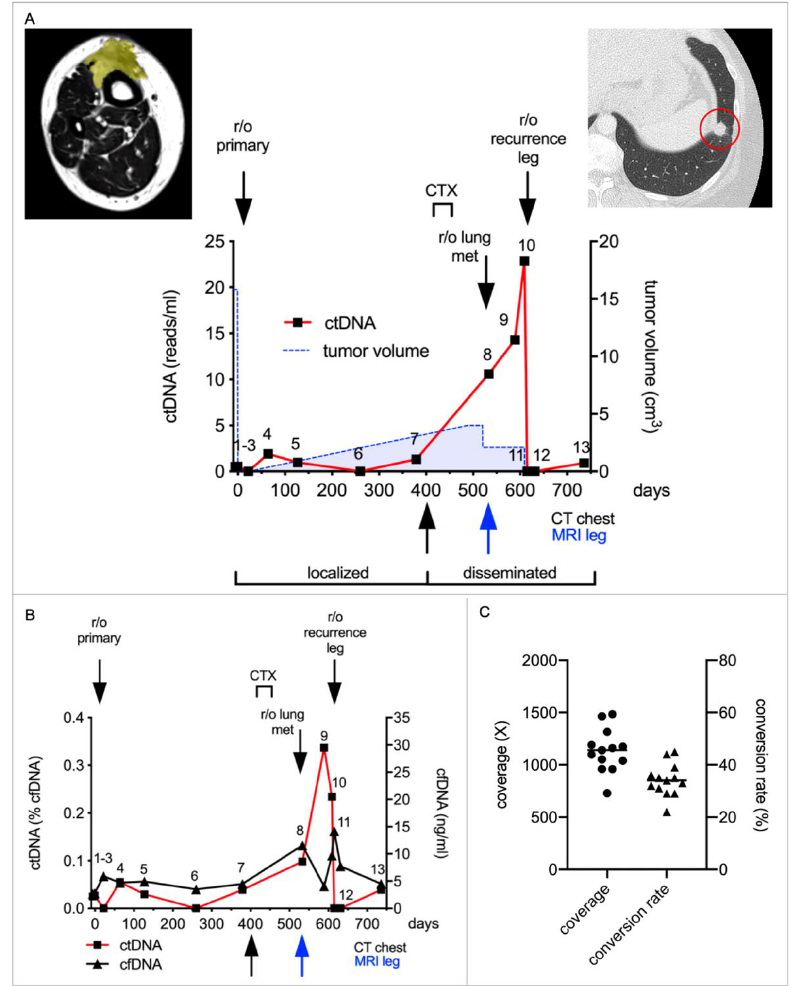
Figure 2. ctDNA enables the detection of local and distant metastases in a patient with leiomyo- sarcoma. ( A ) The patient presented with a primary tumor (yellow, volume: 15.8 cm 3 ) on her shin which infiltrated the tibia as demonstrated in the MRI image (left). After neoadjuvant radiotherapy, the tumor was resected. Routine follow-up according to ESMO guidelines was conducted. In the second year after removal of the primary tumor, lung metastases and a local recurrence were de- tected. As there was progressive disease with chemotherapy (CTX), several lung metastases and the recurrence were resected. An individual mini-panel covering seven mutations identified by exome sequencing was established to quantify ctDNA in 13 plasma samples. Absolute quantification revealed low levels of ctDNA during follow-up, indicating MRD (sample 4–7). Levels rose steadily during progressive disease (sample 8–10) and again decreased after tumor resections (sample 11 and 12). Depicted are absolute amounts of ctDNA (red line). The tumor volume, as calculated from MRI and CT imaging, is depicted by the blue dashed line. Colored arrows indicate the timepoints of CT chest and MRI imaging, at which the recurrence/metastases were first detected. The red circle in the right subfigure demonstrates the representative metastasis in CT chest. ( B ) Depicted are the cfDNA concentrations (black line) and relative amounts of ctDNA (red line) in the same samples. ( C ) shows the coverage (circles) and conversion rate (triangles) of each sample after building UMI consensus families. Means are illustrated by horizontal